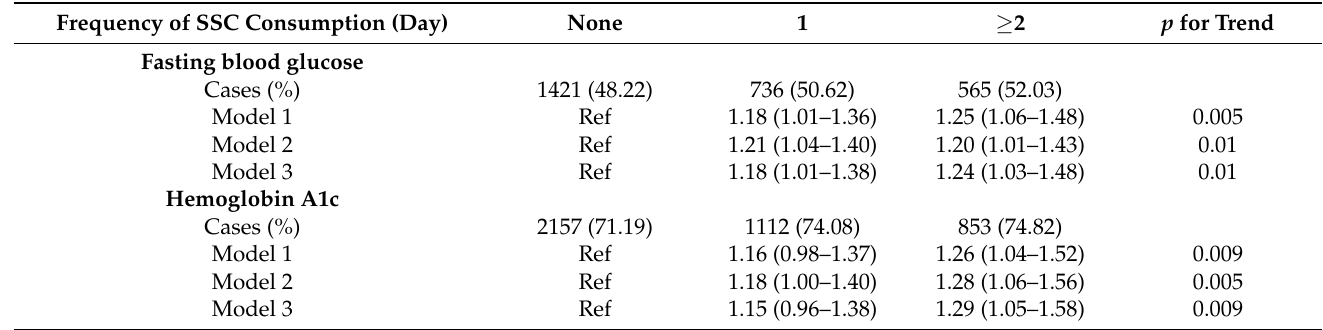
Table 3. Odds ratios (95% confidence intervals) for not achieving the glycemic targets by patients with type 2 diabetes mellitus according to the frequency of sugar-sweetened coffee consumption, KNHANES